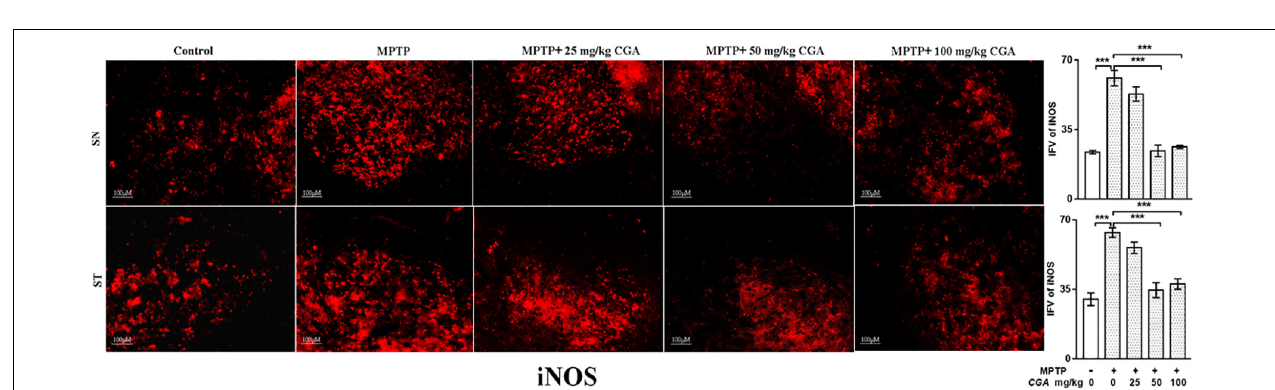
FIGURE 7 | IHC of TNF- α in SN and striatum of mice. With 10 × magnifications after staining. The level of TNF- α was found to be increased in the SN and striatum of MPTP-treated mice compared with control mice, whereas CGA administration to MPTP-injected mice showed moderate staining of TNF- α in the MPTP+CGA mice compared with MPTP-injected mice. Values are expressed as mean ± SEM ( n = 3). ∗ p < 0.05, ∗∗ p < 0.01, and ∗∗∗ p < 0.001. CGA, chlorogenic acid; MPTP, 1-methyl-4-phenyl-1,2,3,6-tetrahydropyridine; SN, substantia nigra; ST, striatum; TNF- α , tumor necrosis factor; SEM, standard error of mean; IFV, integrated fluorescent value.